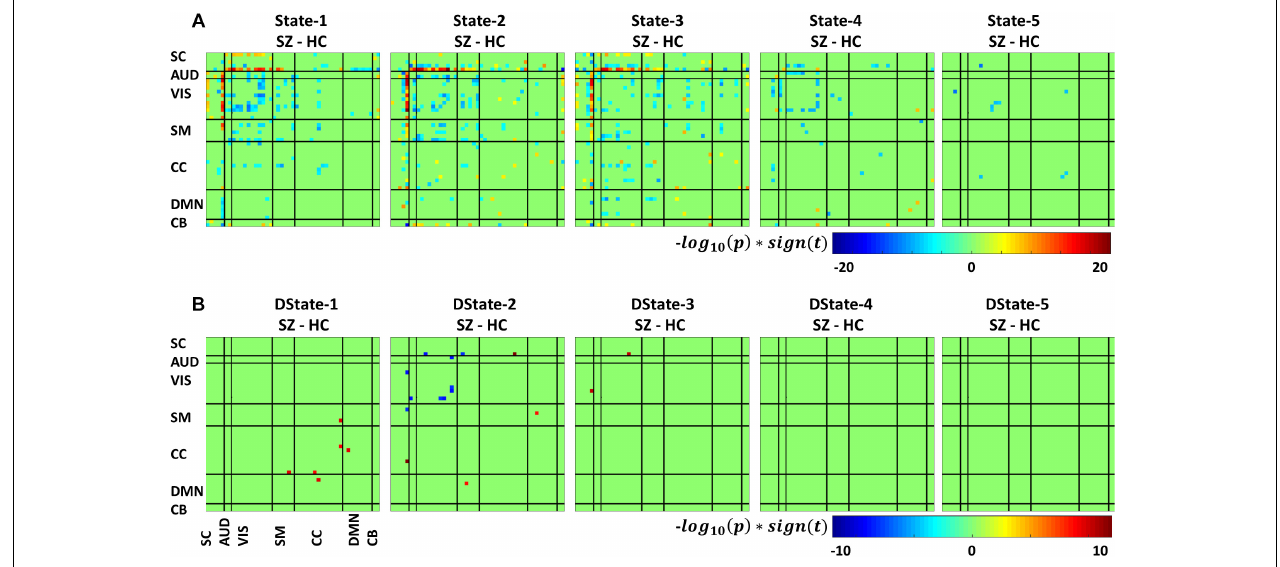
FIGURE 7 | Two t -test results showing states (A) and derivatives (B) connectivity differences between the SZ and HC groups, FDR corrected results threshold at a q <